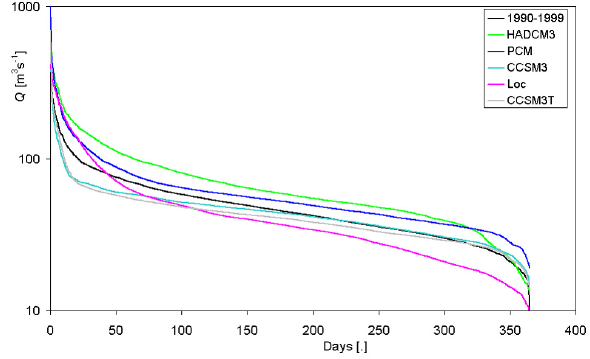
Fig. 10. Oglio at Sarnico. Scenario simulations, period 2045–2054. Flow duration curves. Logarithmic scale is used in y-axis for better readability. CCSM3 and CCSM3 have here differentare plotted in colors for